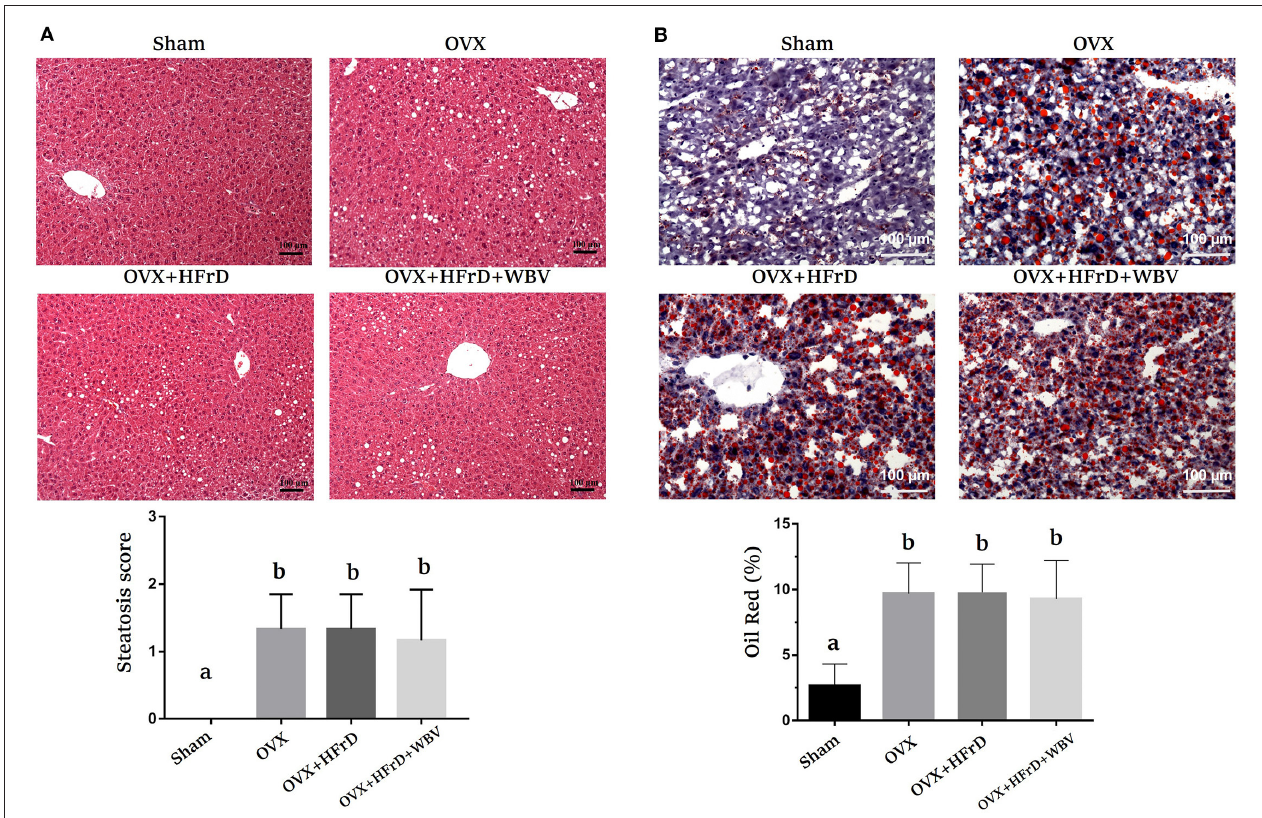
FIGURE 8 | The effects of whole-body vibration (WBV) combined with a high-fructose diet (HFrD) on ovariectomized (OVX) mice in terms of liver steatosis. The livers were individually stained with hematoxylin and eosin (A) and Oil Red O (B) to assess pathological lipid accumulation. The level of severity of the fatty change was categorized as mild (1: 6–33%), moderate (2: 34–66%), or severe (3: 67–100%). The data are presented as means ± SD. Different superscript letters indicate significant differences ( P < 0.05), as indicated by a one-way analysis of